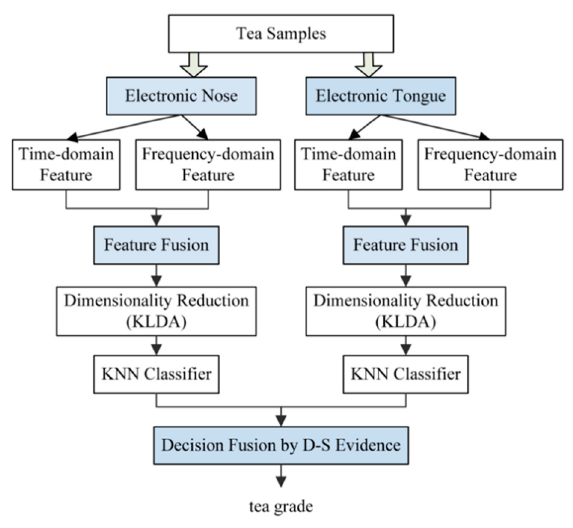
Figure 9. A sensor fusion framework to predict tea of different grade [5].